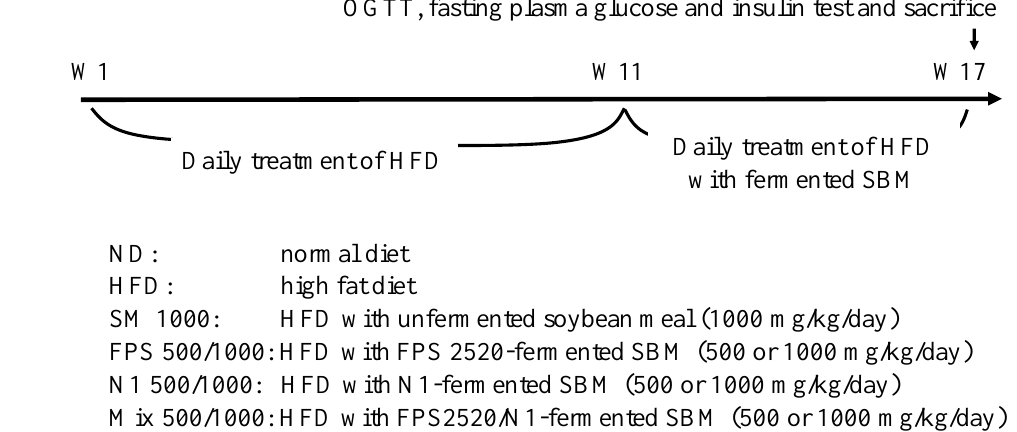
Figure 6. Protocols of fermented soybean meal (SBM) product administered to rats fed a high-fat diet (HFD). SD rats were fed a normal diet for 1 week, and then randomly divided into 9 groups (8 rats per group): normal diet group (ND); HFD control group; HFD with unfermented SBM (SM 1000; 1000 mg/kg); HFD with FPS 2520-fermented SBM (FPS 500 and FPS 1000; 500 and 1000 mg/kg); HFD with N1-fermented SBM (N1 500 and N1 1000; 500 and 1000 mg/kg); and HFD with FPS2520/N1-fermented SBM (Mix 500 and Mix 1000; 500 and 1000 mg/kg). All rats, except those in the ND group, were fed a HFD for 10 weeks, and then various fermented SBMs were orally administered to rats daily for the following 6 weeks. Oral glucose tolerance tests were conducted by orally administering glucose (1.5 g/kg of body weight) to rats, and then blood sampling at 0, 30, 60, 90, and 120 min. Moreover, blood samples were collected after food deprivation of 12 h, and the rats were sacrificed to harvest liver samples for further analysis.